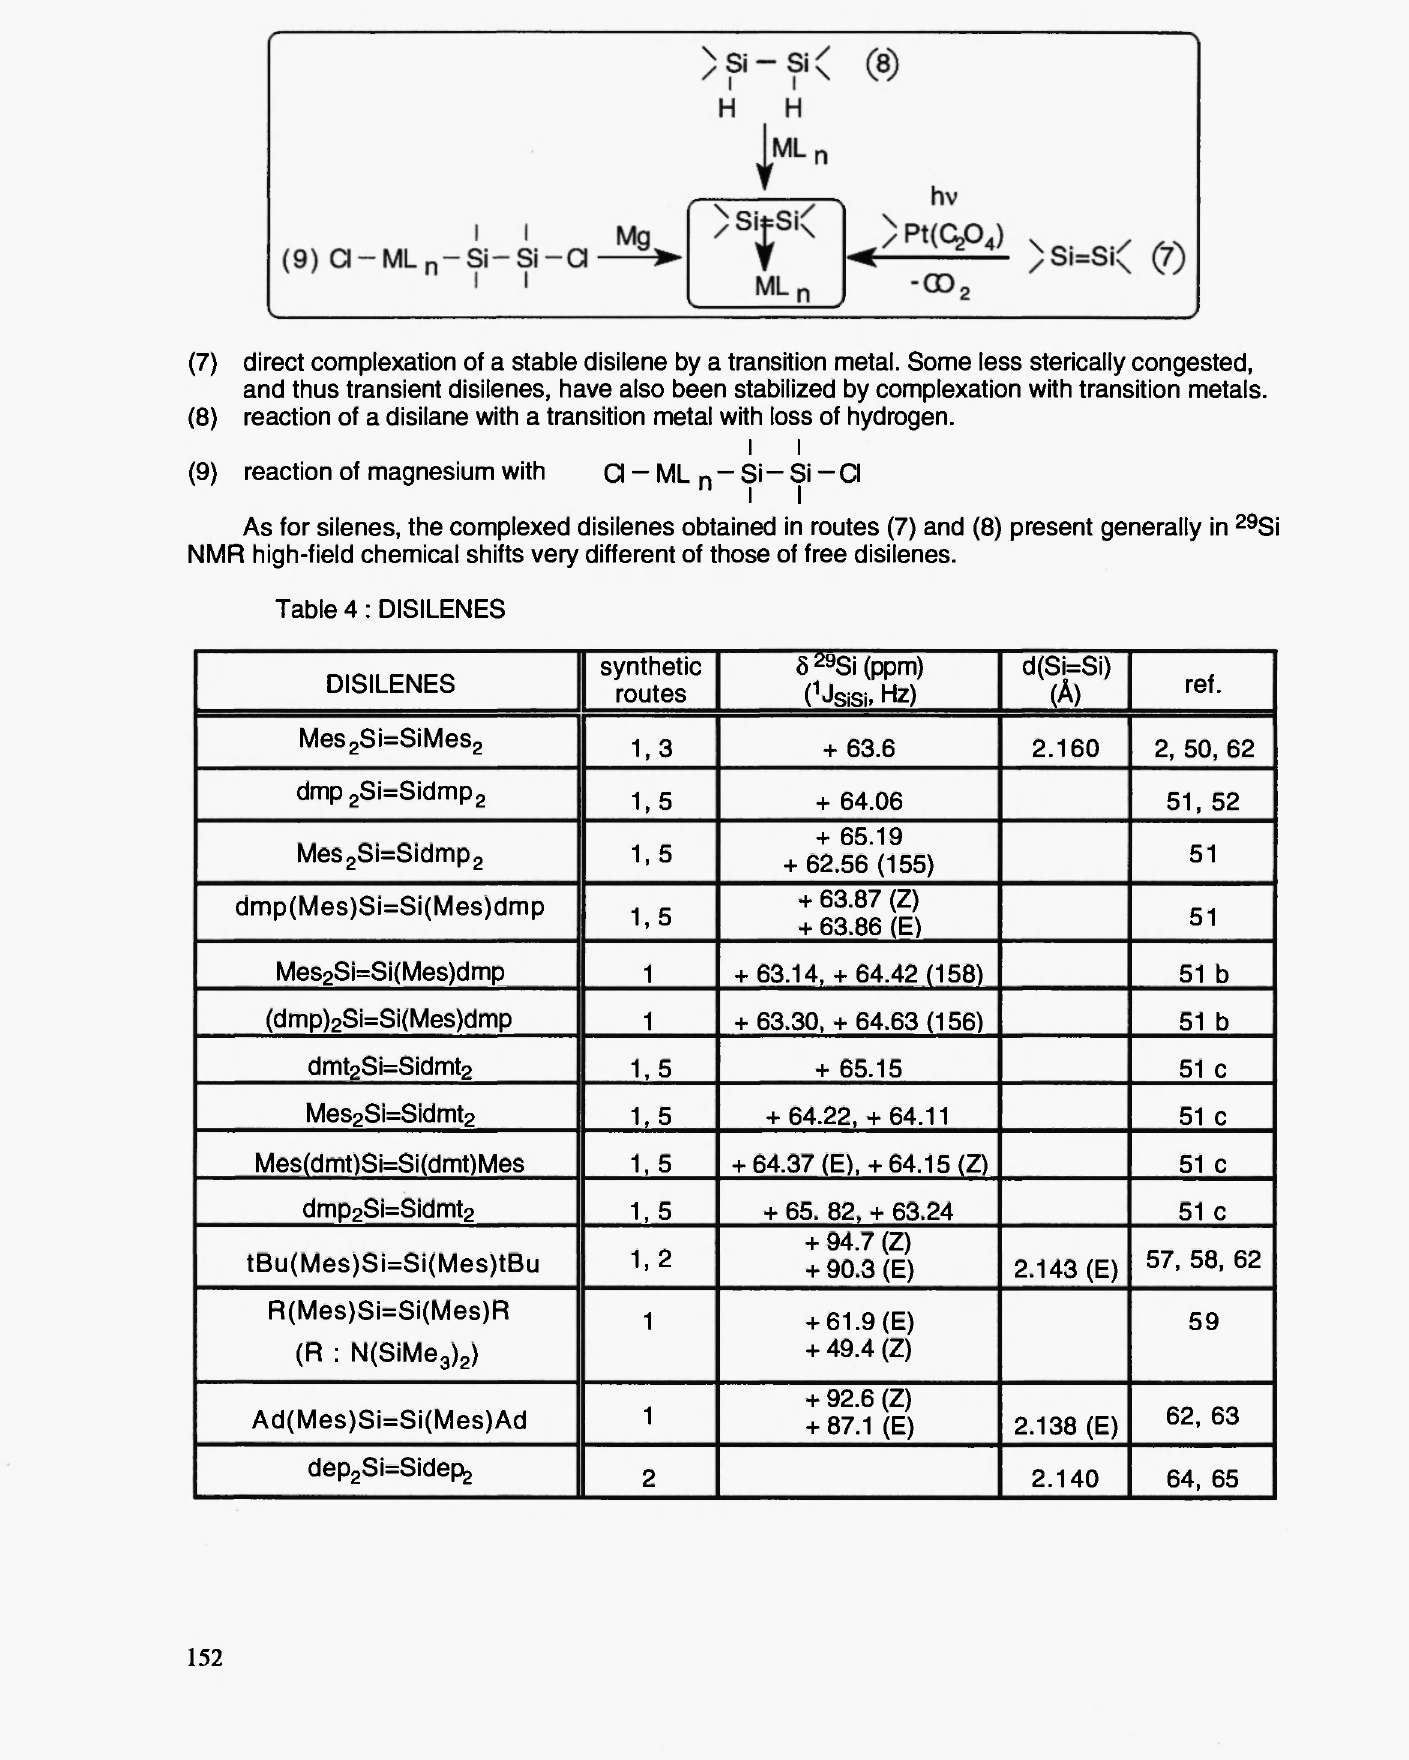
Table 4: DISILENES DISILENES